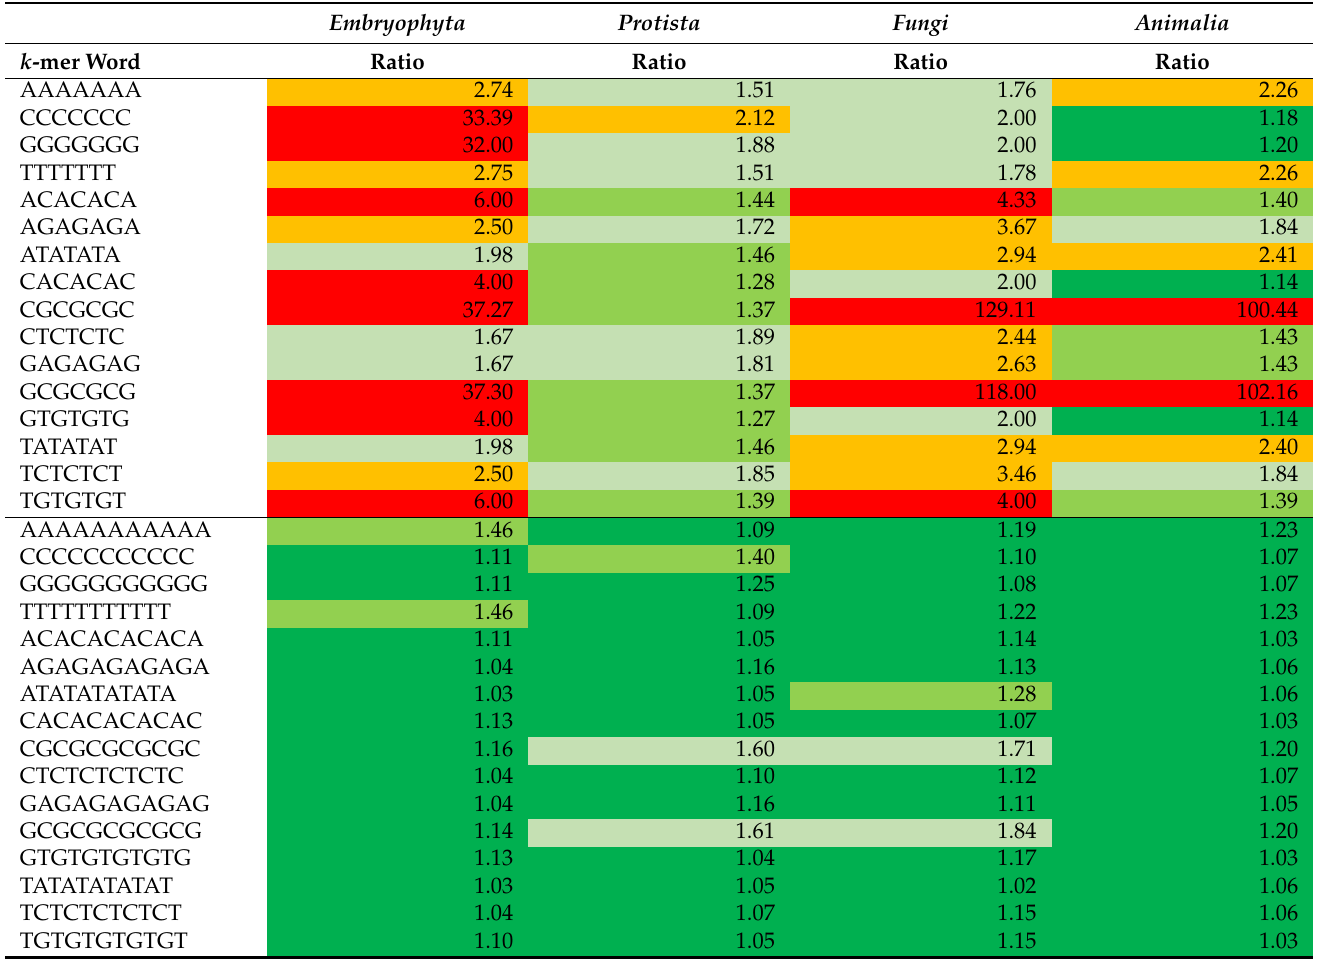
Table 6. Ratio of correlation contributions of tandem repeat words with up to 1 mismatch and no mismatch allowed. The ratios of correlation contributions of tandem repeat words in Table 4 are shown for correlations between introns and intergenic regions for tandem repeat k -mer words with repeat unit length ≤ 2 bp for no and up to one allowed mismatch for k = 7 (top) and k = 11 (bottom). If the value is up to 1.25, the row is highlighted dark green; light green if value is above